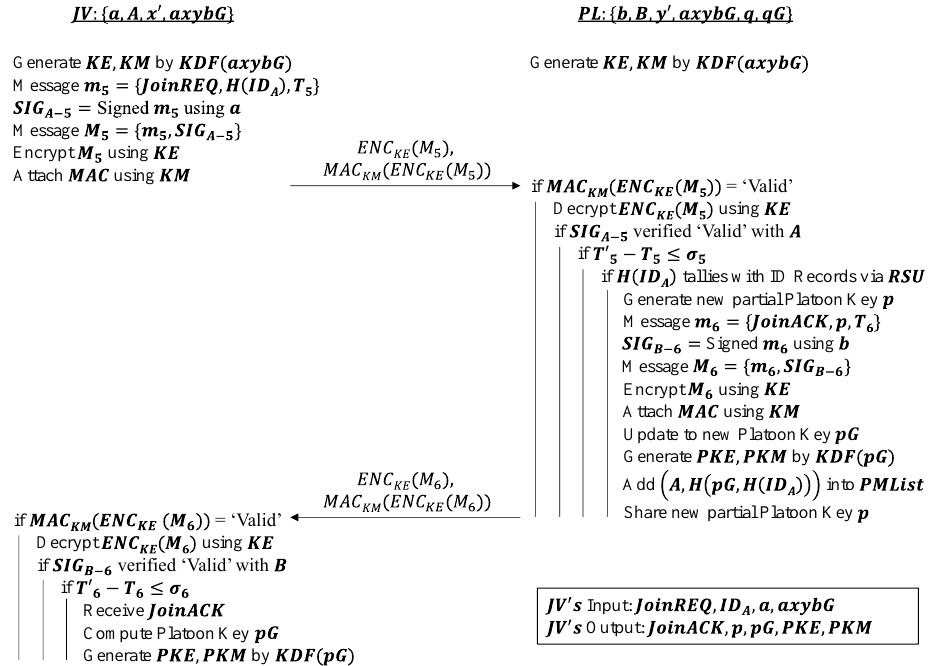
Figure 3. Message Authentication Phase of the SPMSA Scheme.